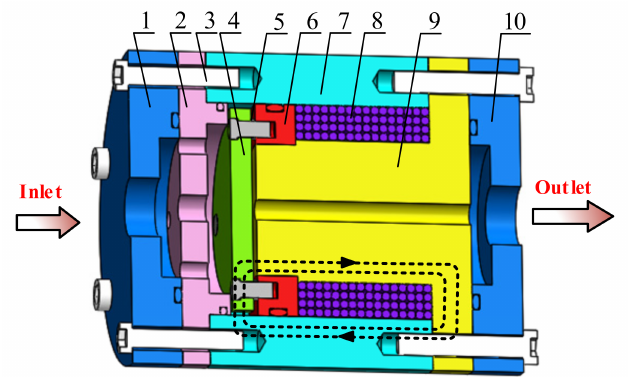
Figure 1. Schematic configuration of the annular-radial-orifice flow MR valve: 1. Left end cover; 2. Flow guided plate; 3. Screw; 4. Magnetic disk; 5. Washer; 6. Positioning plate; 7. Valve body; 8. Excitation coil; 9. Valve spool; 10. Right end